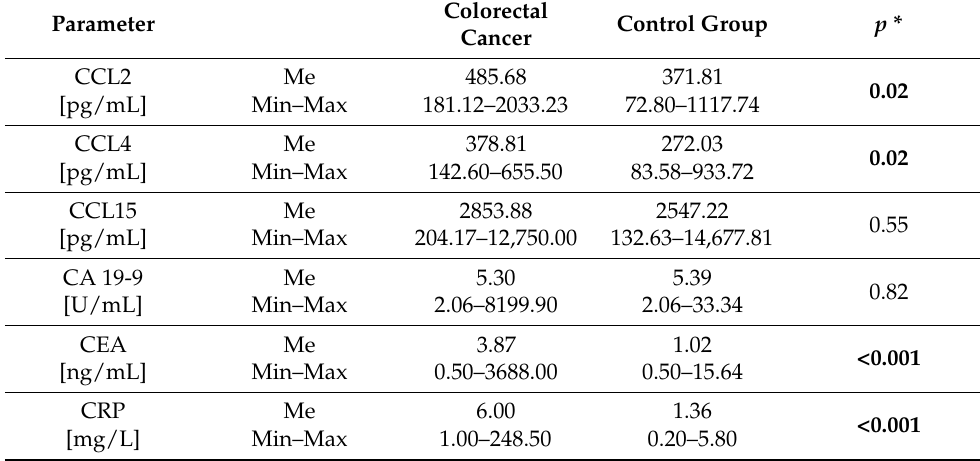
Table 2. Serum levels of tested parameters in cancer and control